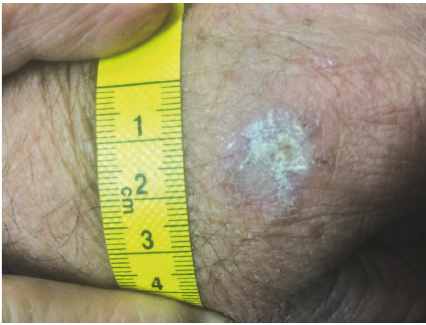
Figure 1: Actinic keratosis on the hand prior to honey treatment.